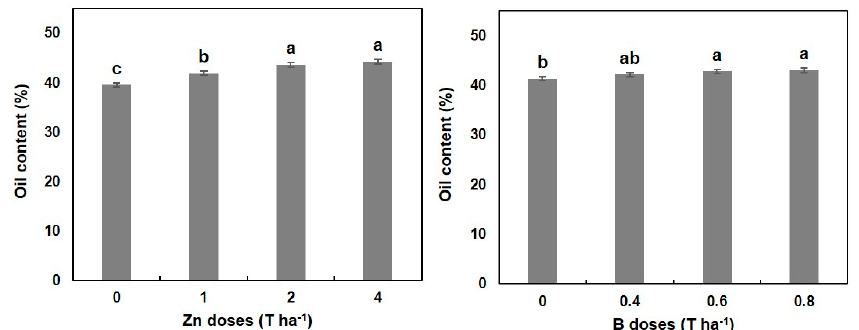
Figure 5. Zn and B’s Impact on Mustard Oil Content. Figures with same letter (s) do not differ significantly, whereas figures with dissimilar letters differ significantly as per DMRT.